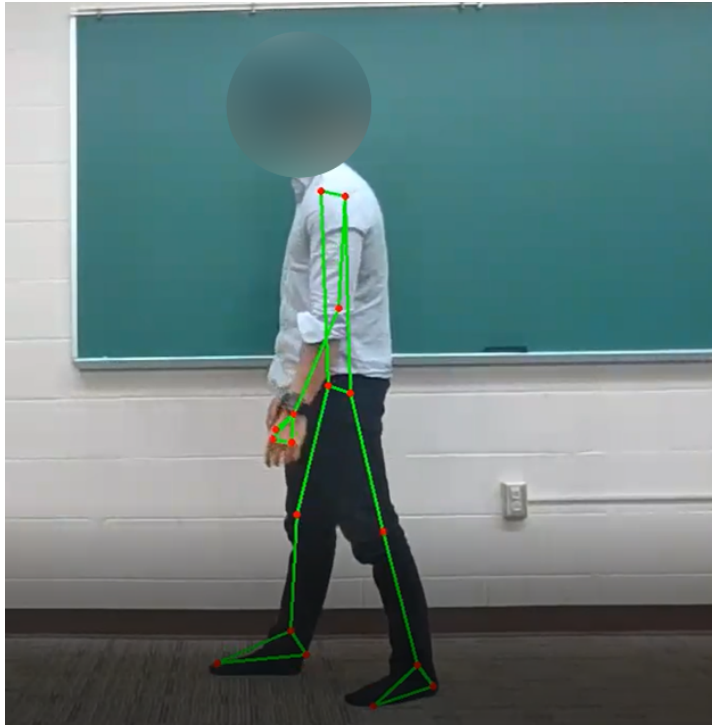
Figure 3. Example of pose estimation using human pose